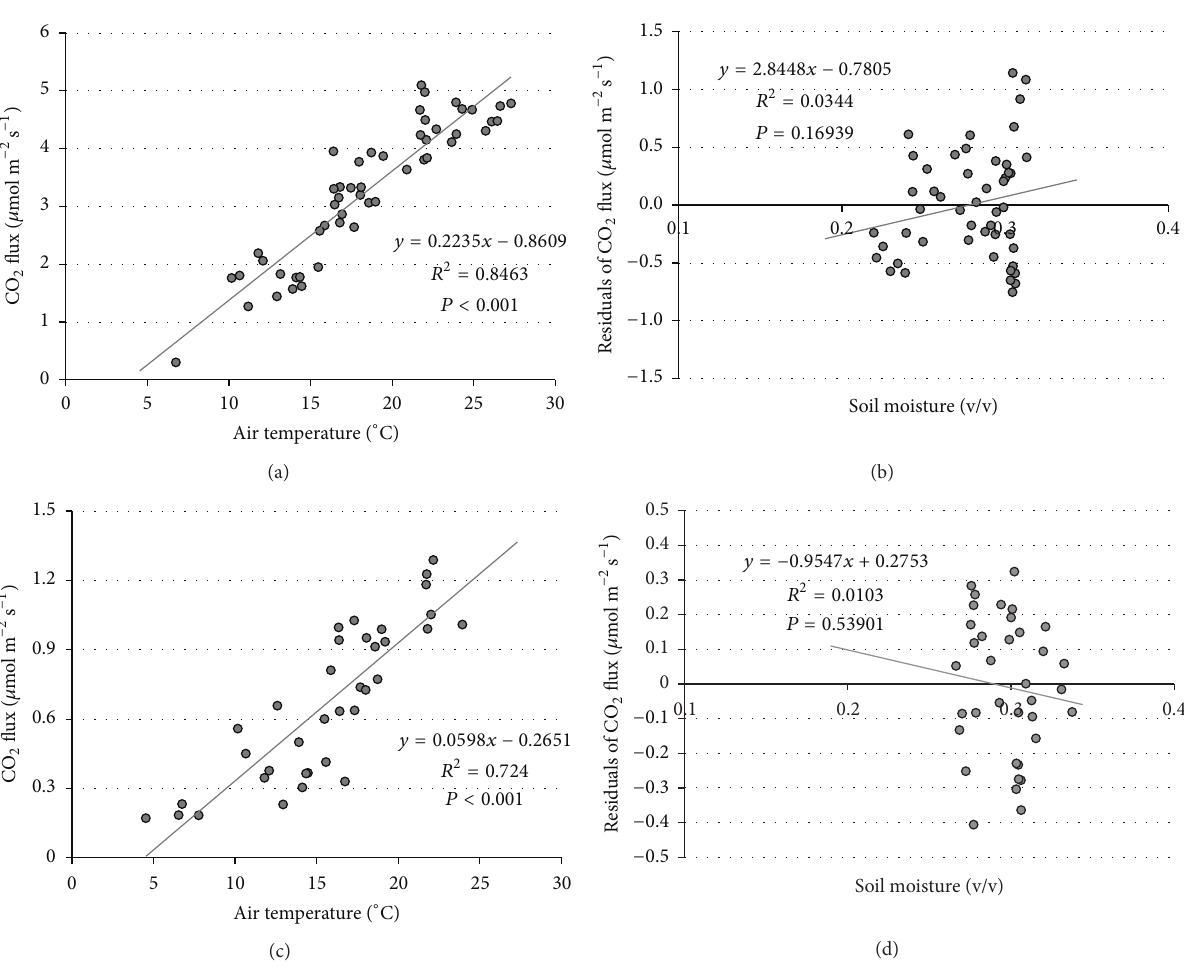
Figure 5: Linear regression between CO 2 fluxes and air temperature and soil moisture in the NT site ((a), (b)) and CT site ((c), (d)). Points represent the daily averages calculated only in the days with full data capturing. The residuals of the CO 2 fluxes which appear in the pictures (b) and (d) are the residuals of the linear regressions shown in the pictures (a) and (c). (CT = conventional tillage site; NT = no-tillage